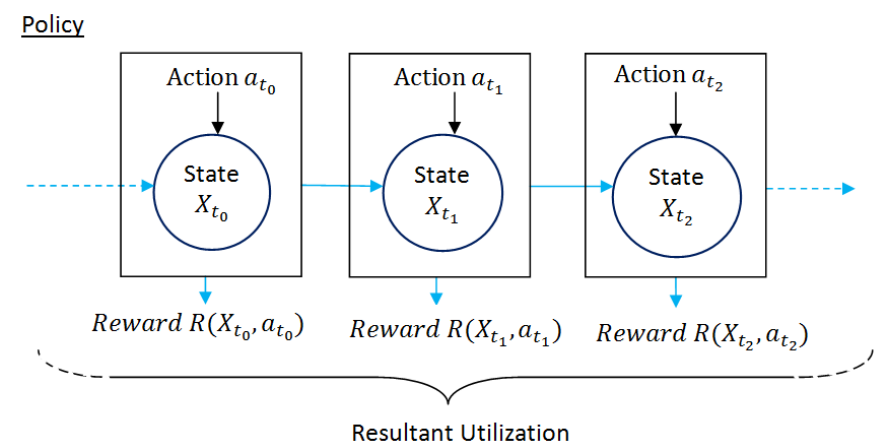
Figure 2. MDP Process Model where t i denotes i -th time